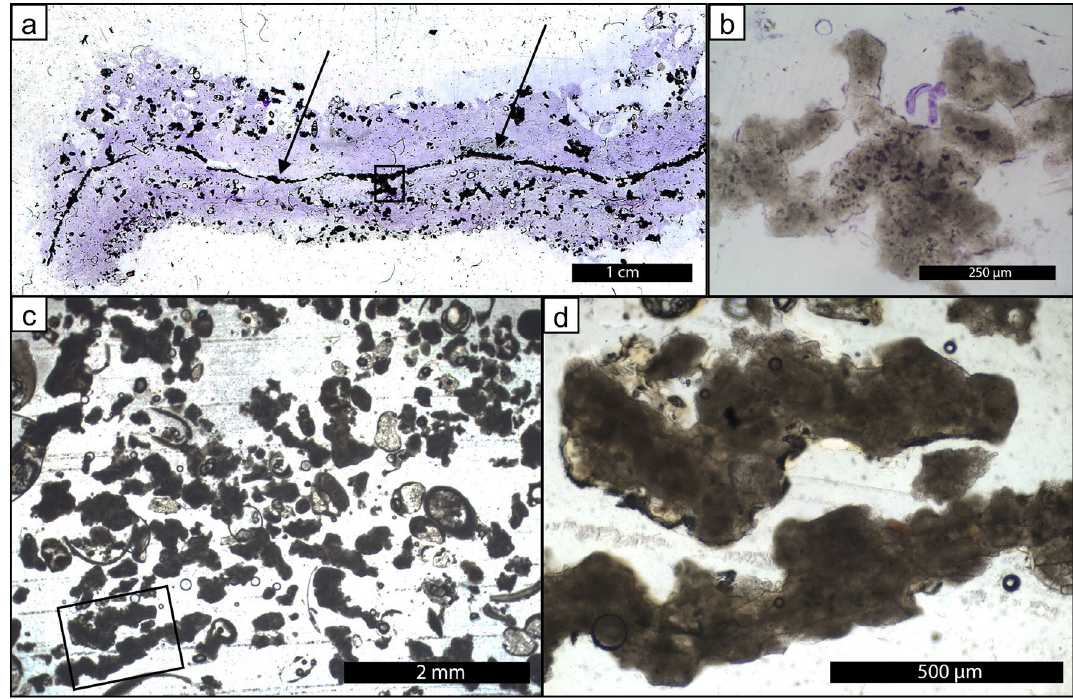
Figure 7. Irregular micritic grain production in gel mats. ( a ) thin section photomicrograph of showing a gel mat intersected by a micritic carbonate laminae and with homogeneous to clotted micritic textures shown in ( b ); ( c ) bulk sediment sample collected from the Booldah Province where irregular micritic grains can make up more than 75% of the total sediment; ( d ) high resolution image of micritic grains from box in ( c ) showing the characteristic irregular, often platy morphologies.